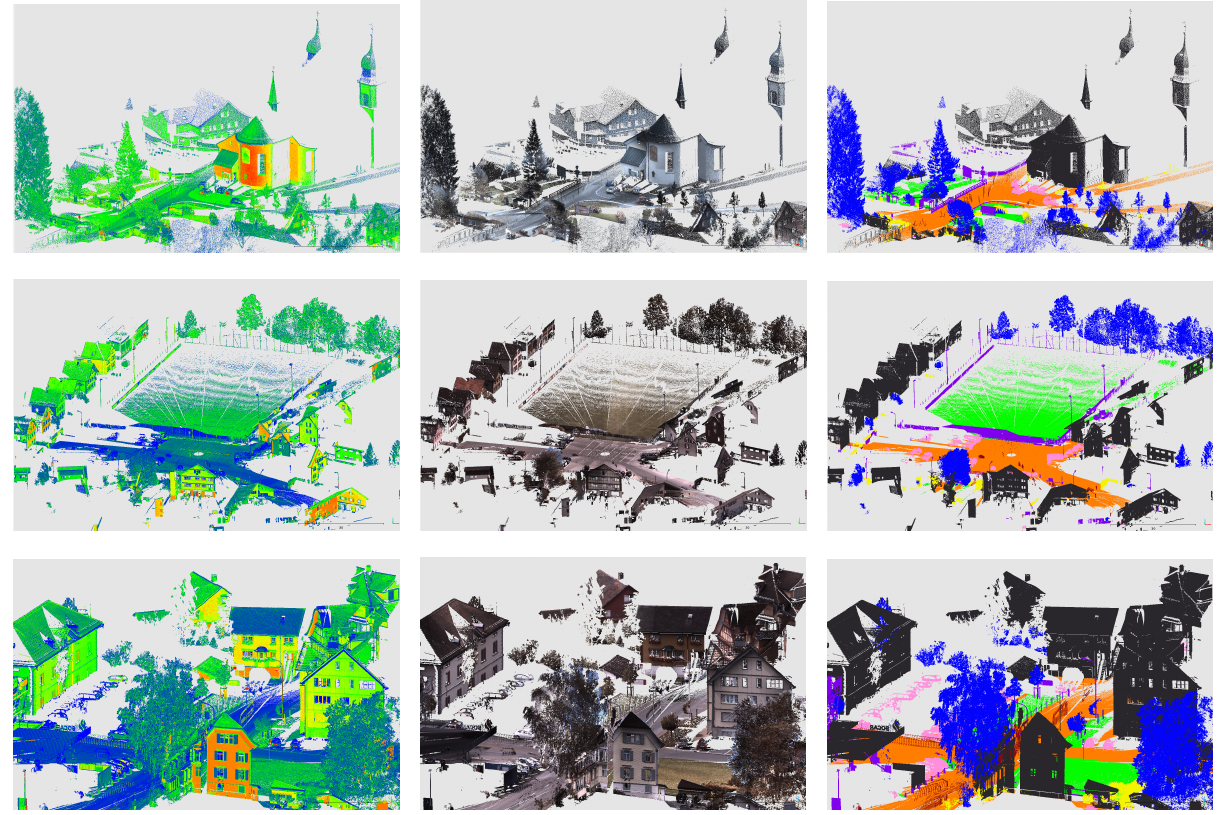
Figure 4: Intensity values (left), rgb colors (middle) and class labels (right) for example data